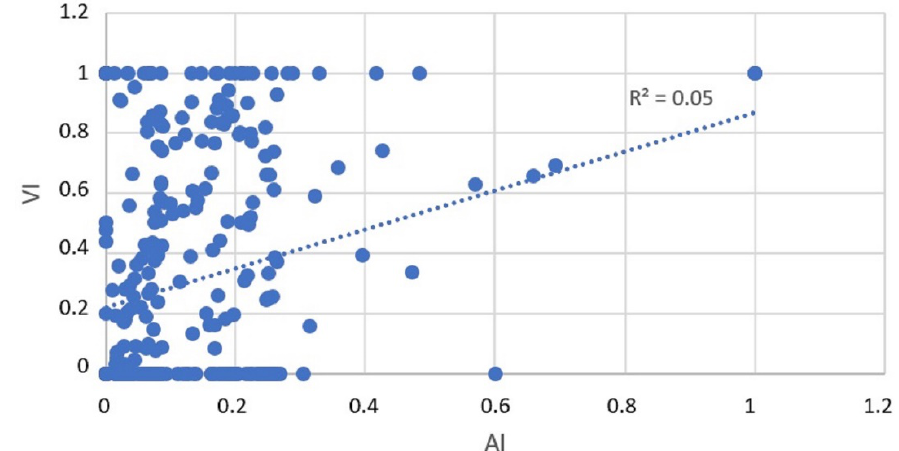
Figure 3. Chart with relation, per plot, between Accessibility Index (AI) on the x-axis and Visibility Index (VI) on the y-axis.